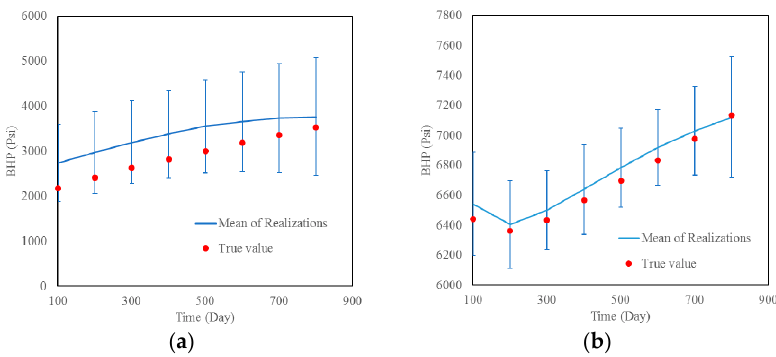
Figure 10. The predictions (mean with the 95% confidence intervals) before history-matching: ( a ) Producer BHP; ( b ) Injector BHP.